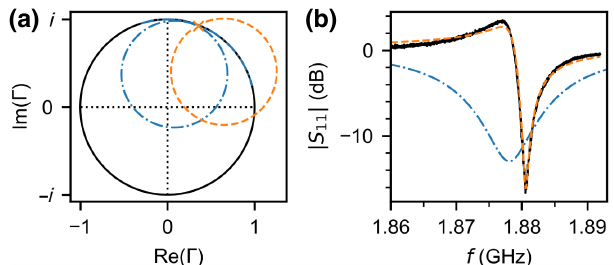
FIG. 9. Simulated resonator response. (a) Simulated reflection coefficient is plotted on a Smith chart for a range of frequen- cies around resonance. The orange dashed line gives the response simulated by the simplified circuit model shown in Fig. 7, which has rotated about its origin on the edge of the circle by 48 ◦ to reproduce the asymmetry observed in the magnitude data. The blue dash-dot line gives the response simulated using the com- bination shown in Fig. 8. (b) We plot the absolute value of the reflection coefficient on the dB scale against frequency. The experimental data from Fig. 1(c) is included in